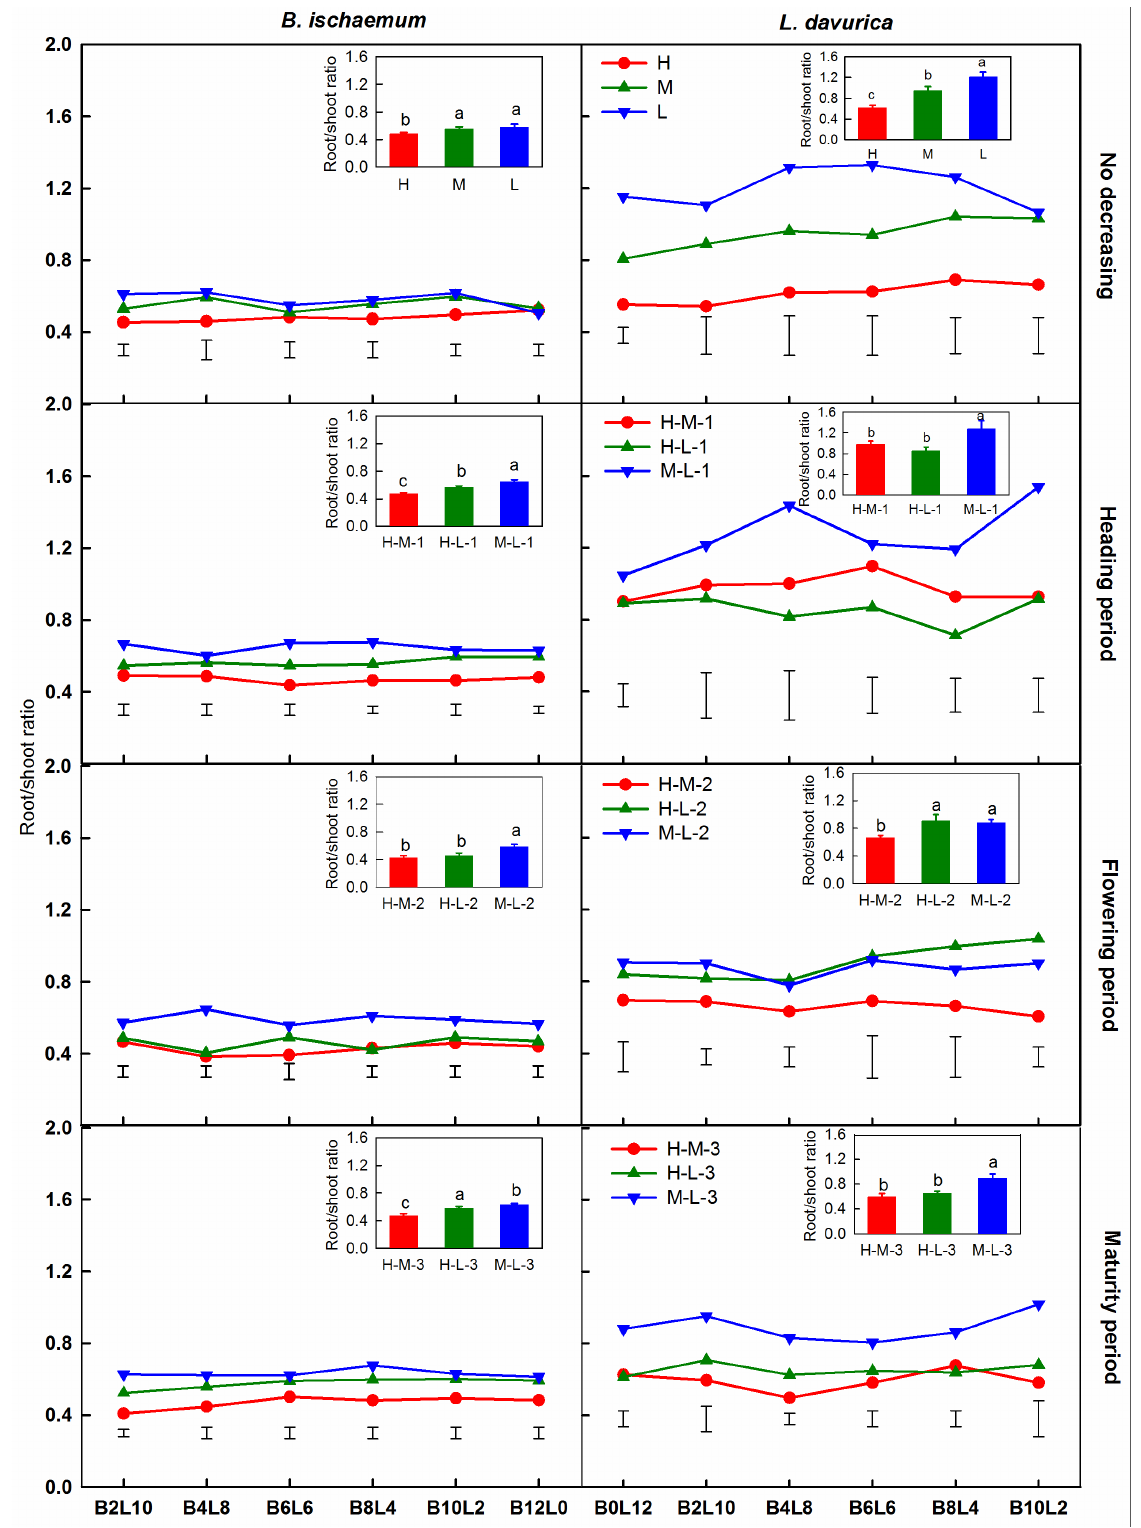
Figure 3. Root/shoot ratio (RSR) of B. ischaemum (B) and L. davurica (L) under soil water decreasing treatments in their mixtures. Vertical bars represent LSD 0.05 values. Inset: mean ( ± SE) RSR across all mixture ratios, different letters indicating significant differences between soil watering treatments ( p < 0.05).